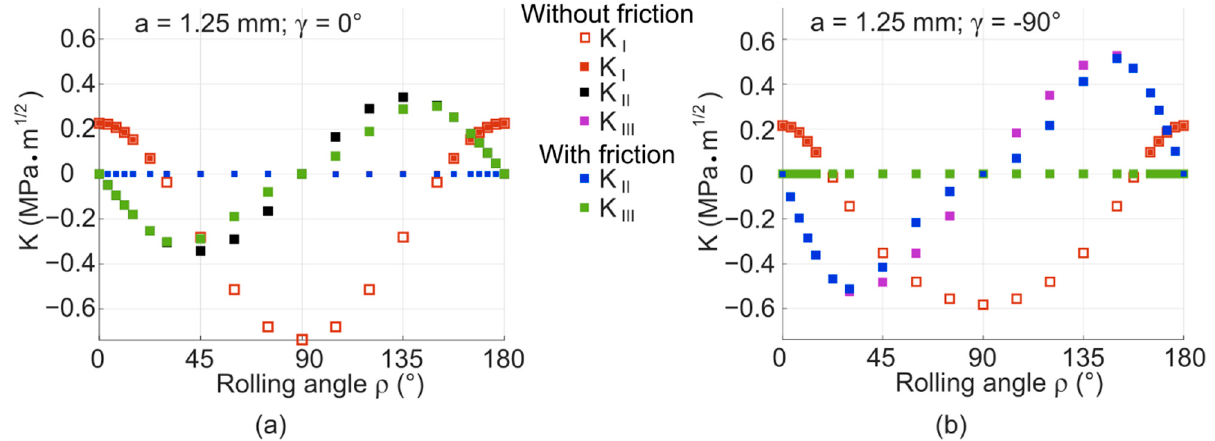
Figure 16. Comparison of stress intensity factor values for the model with void without friction and with friction: ( a ) D × L = 6 × 6 mm 2 , a = 1.25 mm; γ = 0°; ( b ) D × L = 6 × 6 mm 2 , a = 1.25 mm, γ = − 90°.